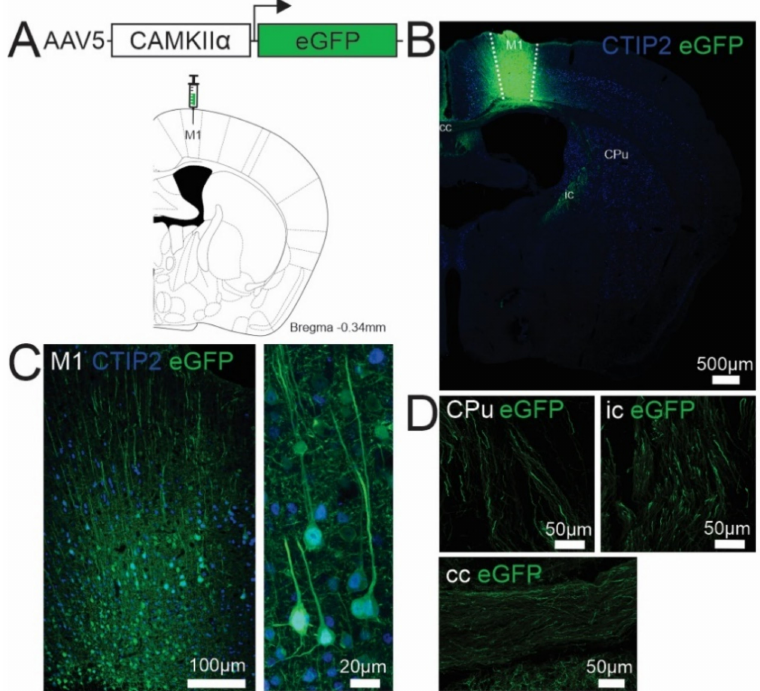
Figure 1. ( A ) Schematic representation of AAV5-CAMKII α -eGFP viral construct and coronal section depicting stereotaxic targeting to the mouse primary motor cortex (M1, coronal brain image adapted from the mouse brain atlas, Paxinos and Franklin 2001). ( B , C ) Representative immunofluorescence images showing eGFP (green) expression is anatomically confined to the M1 and within the somata and atypical dendrites of CTIP2 (blue, a marker for Layer 5 cortical neurons)-positive Layer 5 neurons. ( D ) eGFP-positive fibres are expressed within the caudate putamen (CPu), internal capsule (ic) and corpus callosum